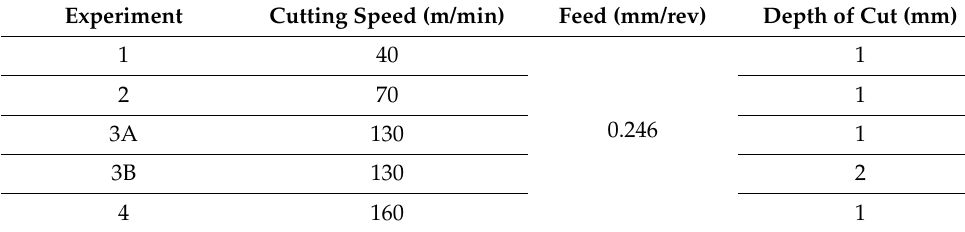
Table 2. Dry turning tests cutting parameters.